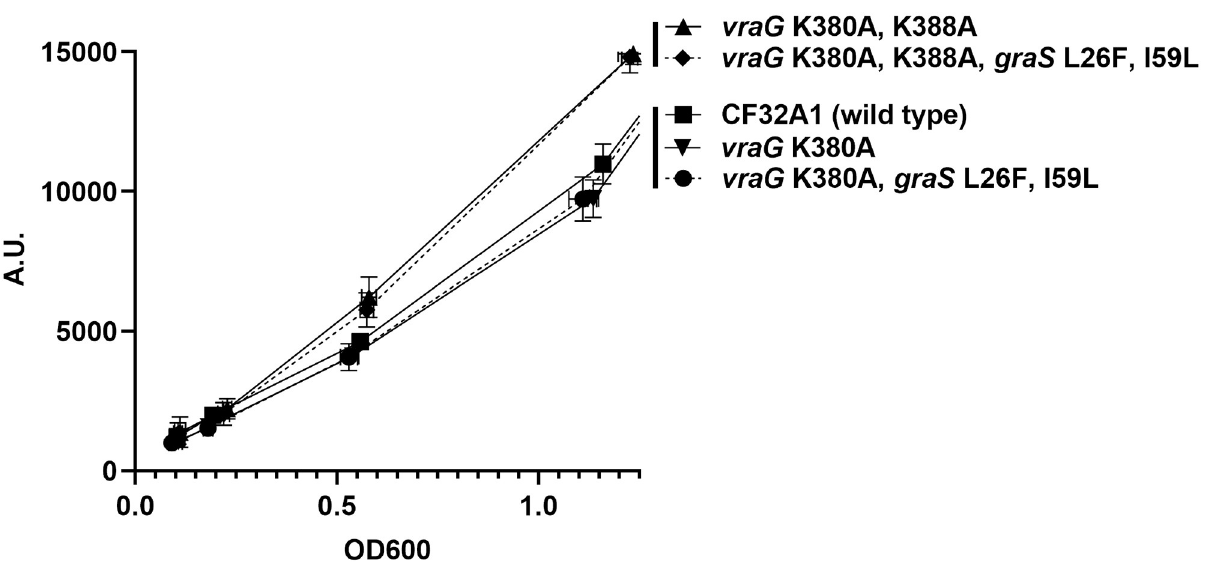
Fig 3. The effects of GraS L26F, I59L on mprF expression in VraG K380A mutant. The expression of mprF promoter fused with a GFPuvr reporter were monitored from the wild type strain and four mutants. All the values were calculated from three biological replicates. The dashed lines indicate the mutants with graS L26F,